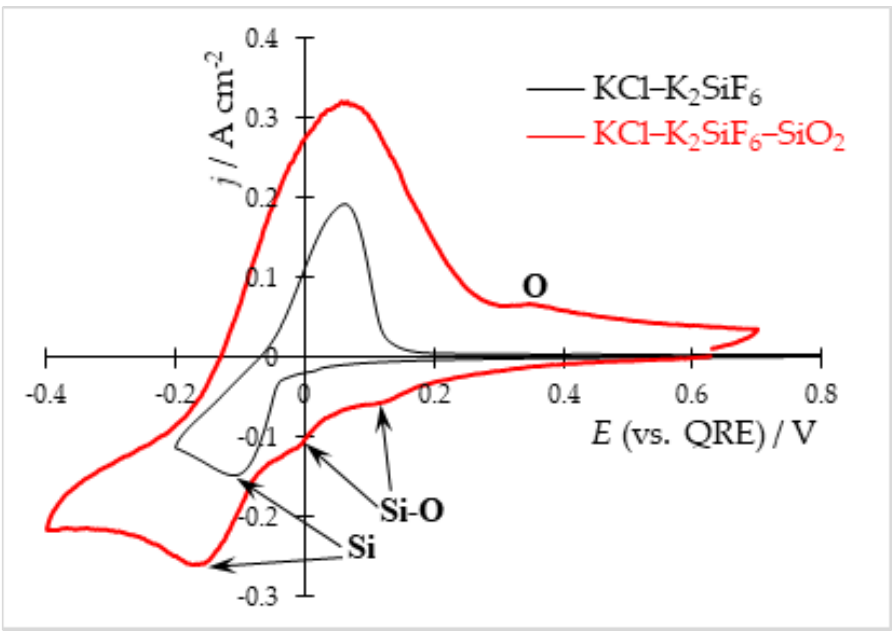
Figure 5. Cyclic voltammograms for the KCl–K 2 SiF 6 and KCl–K 2 SiF 6 –SiO 2 melts with a total silicon content of 0.05 and 0.15 wt.%, respectively. Potential sweep rate is 0.4 V s − 1.